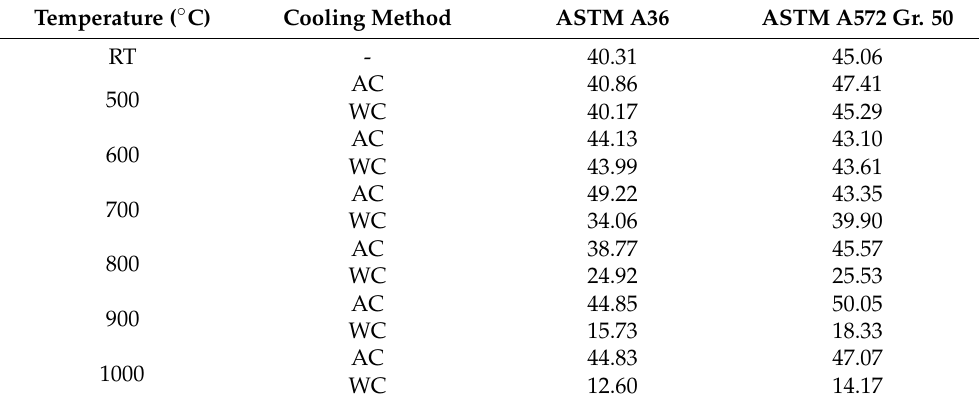
Table 1. Post-fire ductility (%) of SPR specimens made of ASTM A36 and A572 Gr. 50 steels 1 . Temperature ( ◦